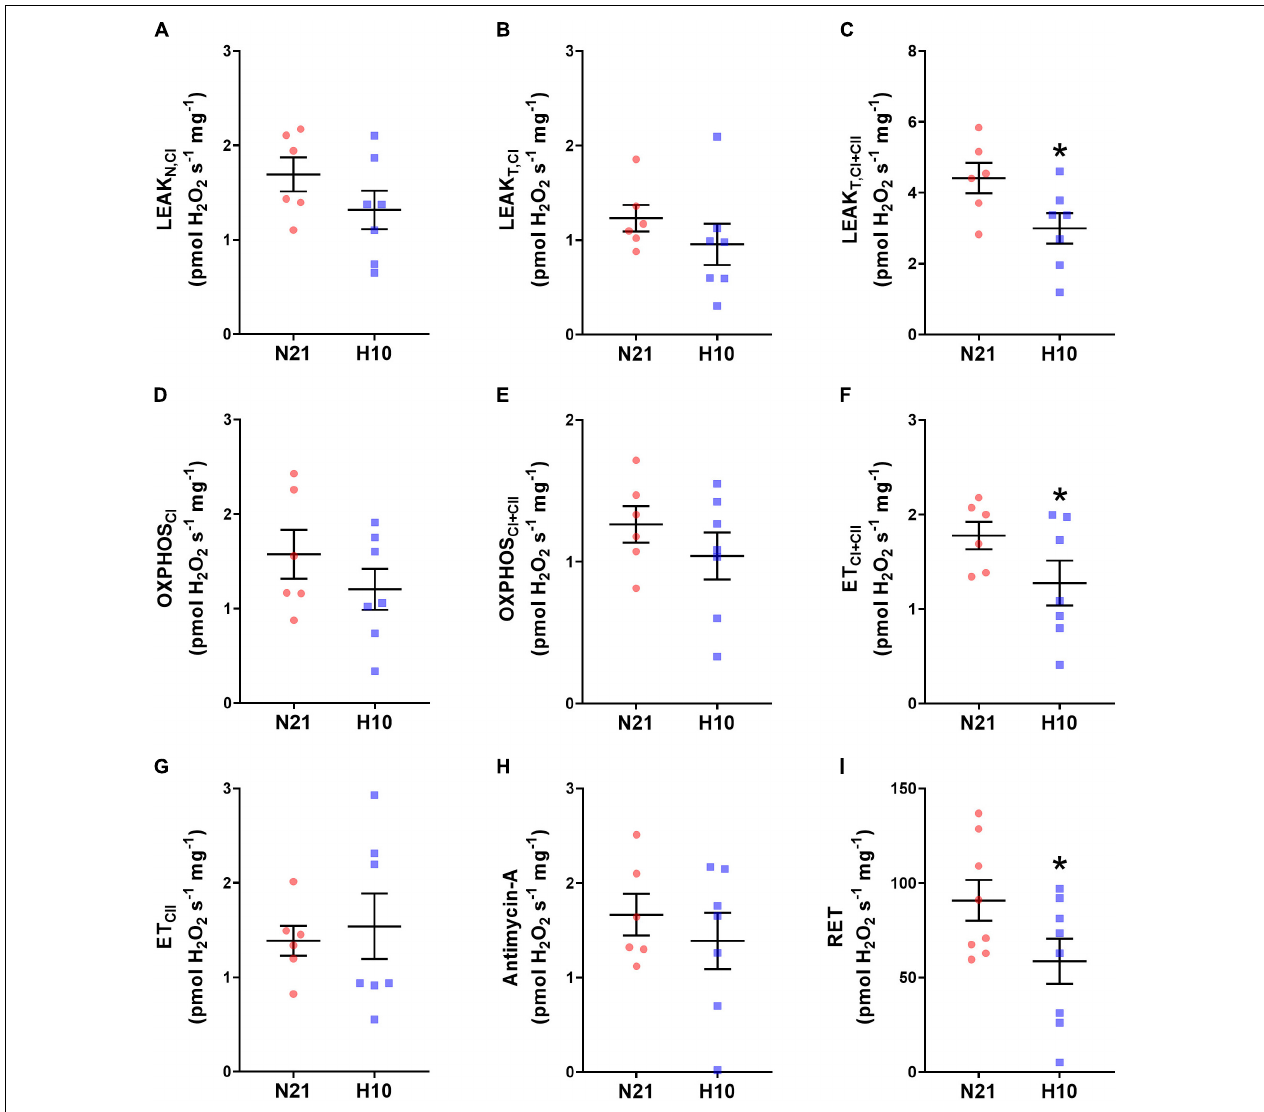
FIGURE 3 | Effect of developmental hypoxia on mitochondrial H 2 O 2 production. Mitochondrial H 2 O 2 production was measured in juvenile snapping turtles from normoxic (N21, red circles, n = 6) and hypoxic H10 (blue squares, n = 7) incubation. Each panel represents a respiratory state. (A) Leak respiration with